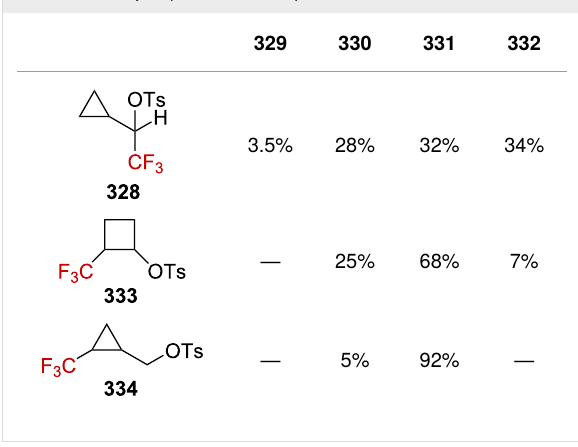
Table 3: Solvolysis products of compounds 328 , 333 , and 334